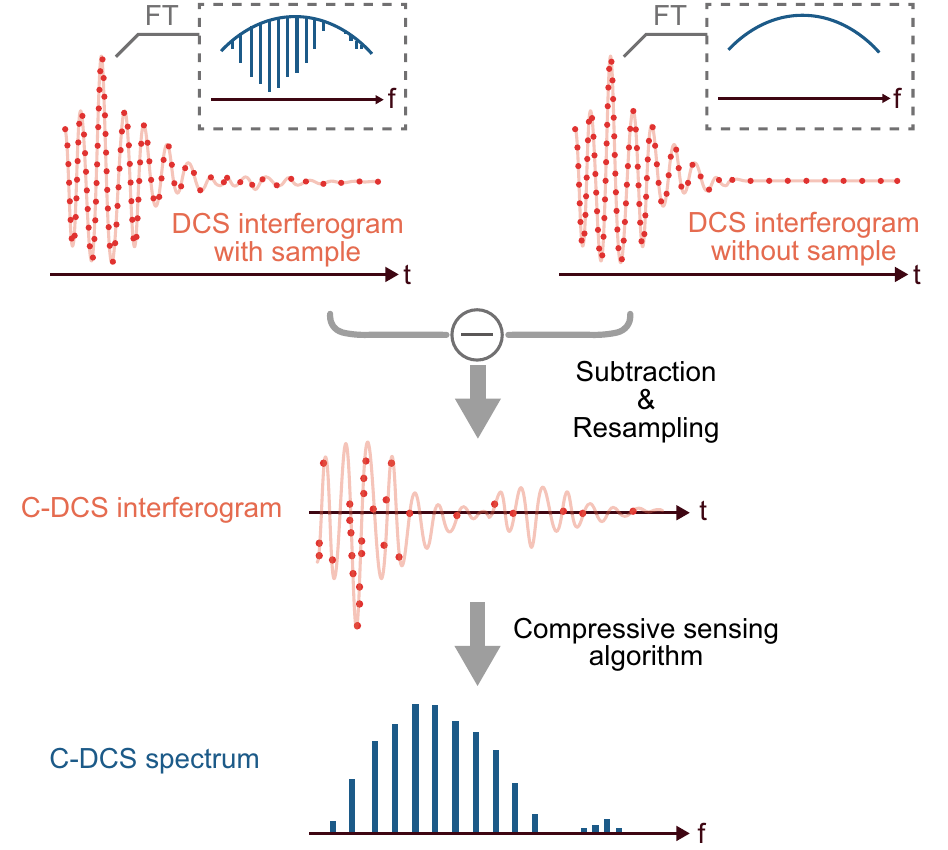
Figure 1. A conceptual illustration of compressive dual-comb spectroscopy